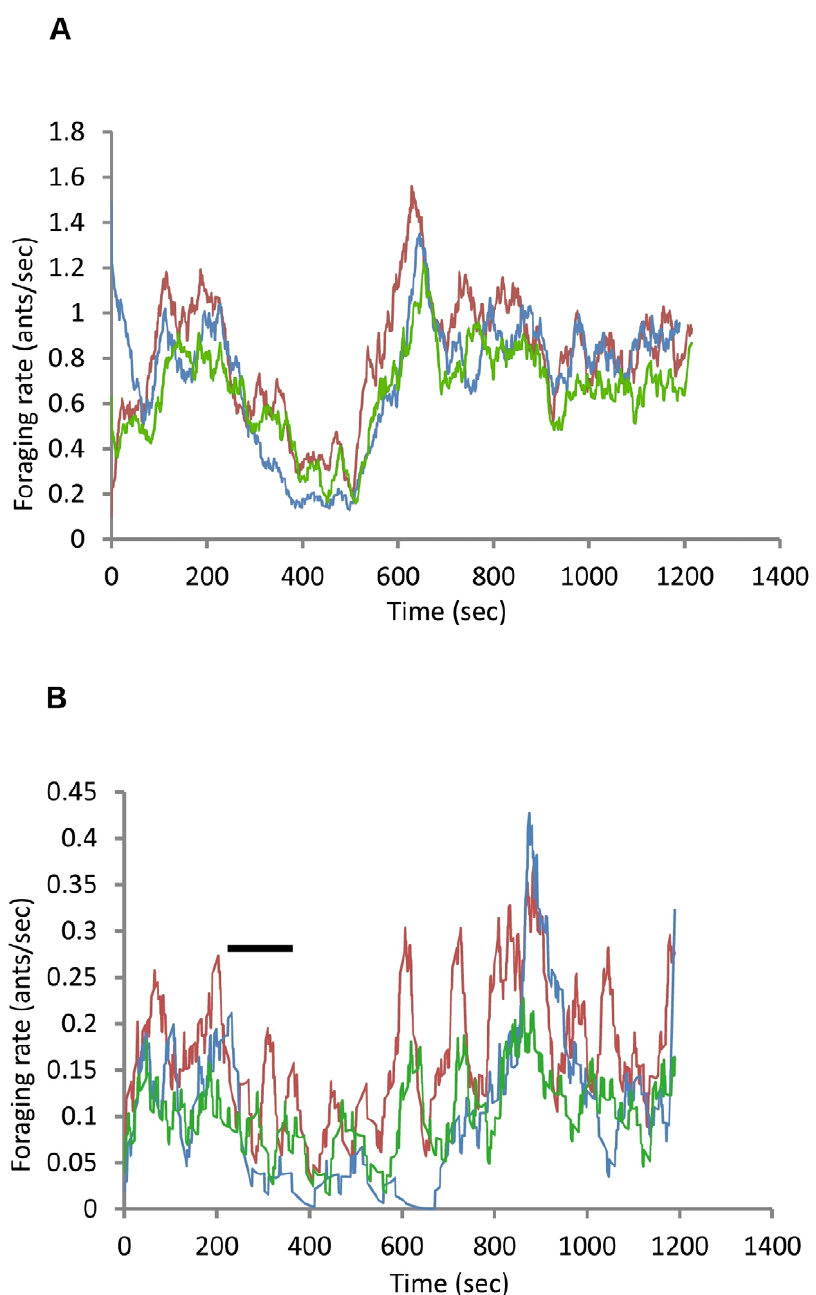
Figure 2. Comparison of observed and simulated foraging rates. The rate of returning foragers was experimentally decreased by removing the returning foragers, leading to a decrease in the rate at which outgoing foragers left the nest. Each figure shows data from one trial. Returning foragers were removed from 240–420 sec, during the interval indicated by the horizontal black line, and then allowed to return to the nest undisturbed for the remainder of the trial. The red line shows the observed rate of returning foragers, the blue line shows the observed rate of outgoing foragers, and the green line shows the simulated rate of outgoing foragers. a, high foraging rate (mean rate returning foragers 0.807 ants/ sec); b, low foraging rate (mean rate returning foragers 0.169 ants/sec). The model has four parameters: a , c , q and d . We examined the fit here; however, empirical studies show that d may be an important between model and data for one parameter, c . We thus fixed a ., q parameter because it may vary by colony [29], or in response to and d and varied c . As with any birth-death process, the ratio of c to e variation in environmental conditions that could affect the rate of determines the distribution of { a n }. We set q to 0.05 to keep the decay of chemical cues such as the cuticular hydrocarbons that ants range of values of a n within the range of observed foraging rates assess by antennal contact [24]. Similarly, a , the baserate of (0.15 to 1.2 ants per sec). We set d to 0 for the simulations reported foraging, was very small, equal to 0.01 ants per second [27].